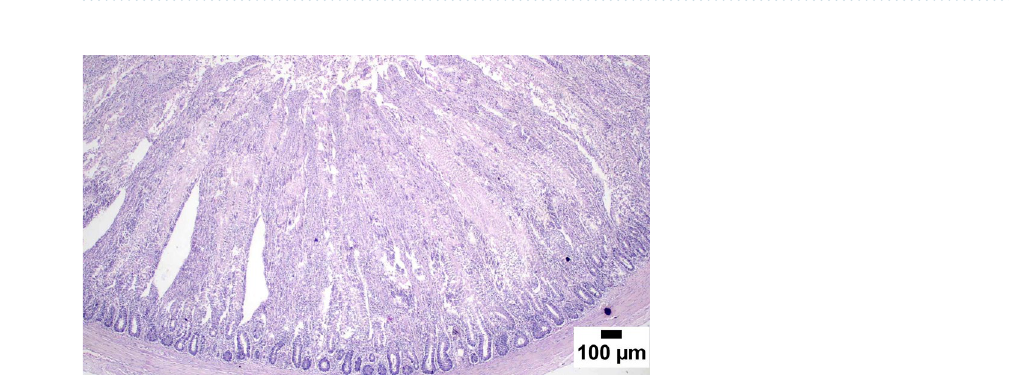
Figure 6. Photomicrograph of the duodenum, D group at 35 days showing ostensibly normal intestinal villi